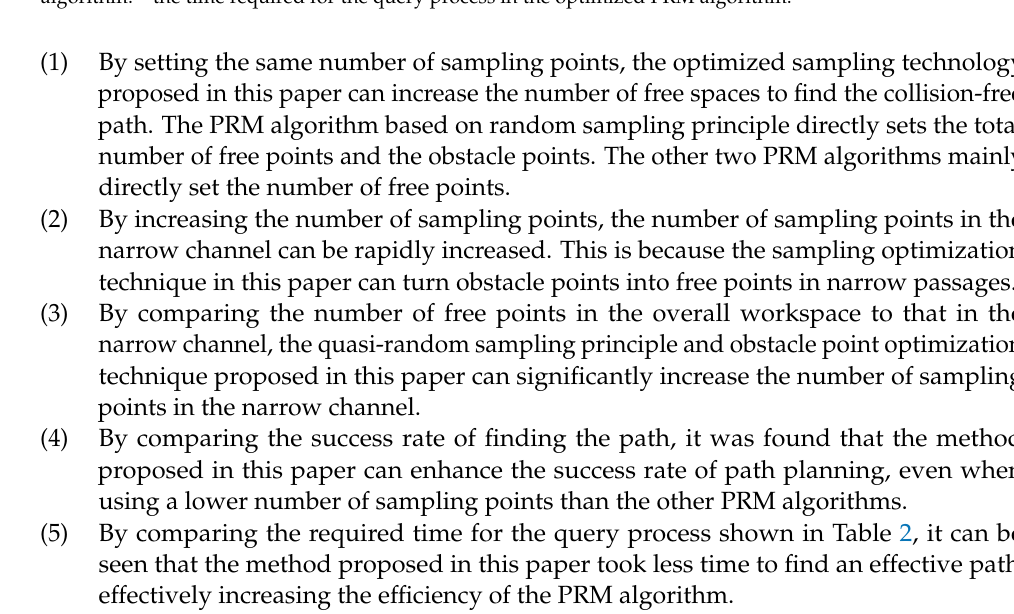
algorithm. 3 the time required for the query process in the optimized PRM